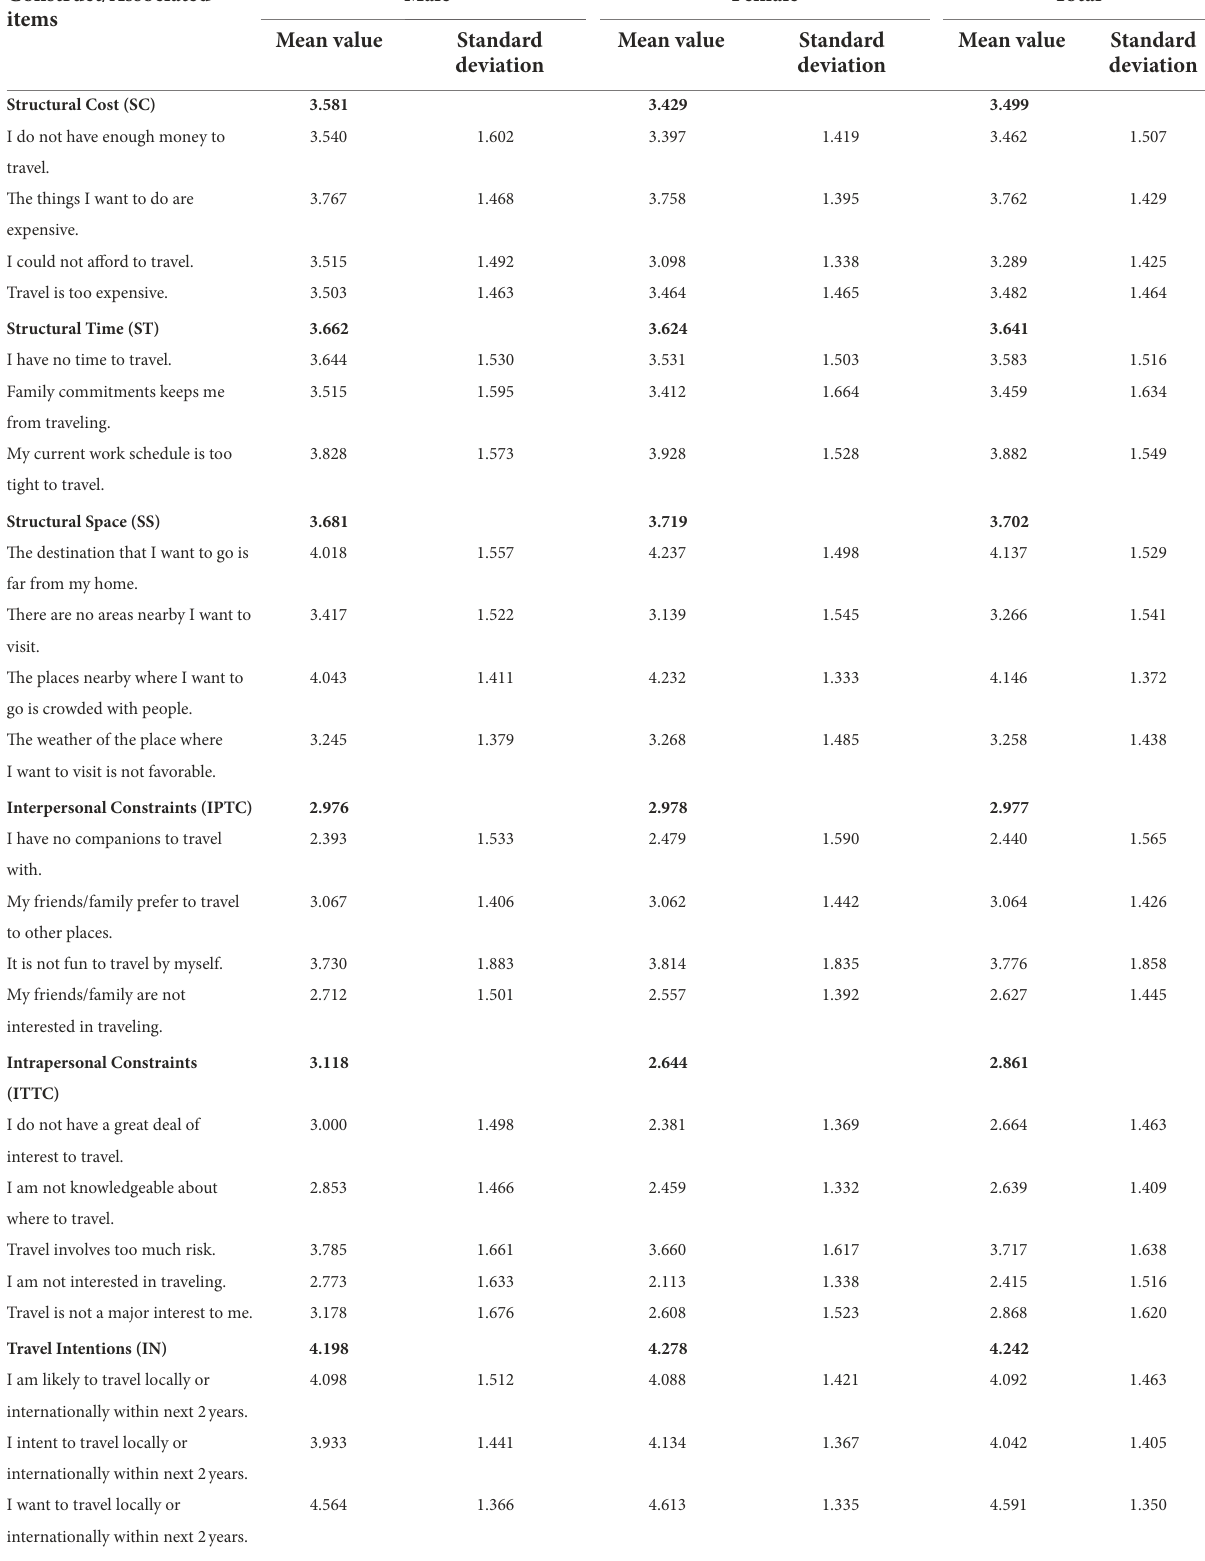
TABLE 1 Descriptive